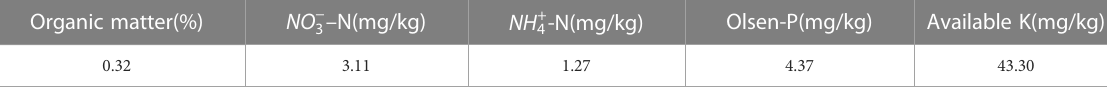
TABLE 1 The chemical properties of the experimental